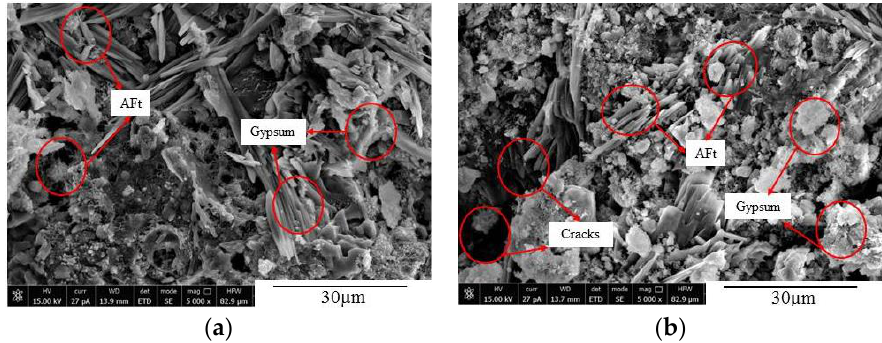
Figure 15. Growth and aggregation of products in FA10 concrete. ( a ) FA10-D90 and ( b ) FA10-D150.